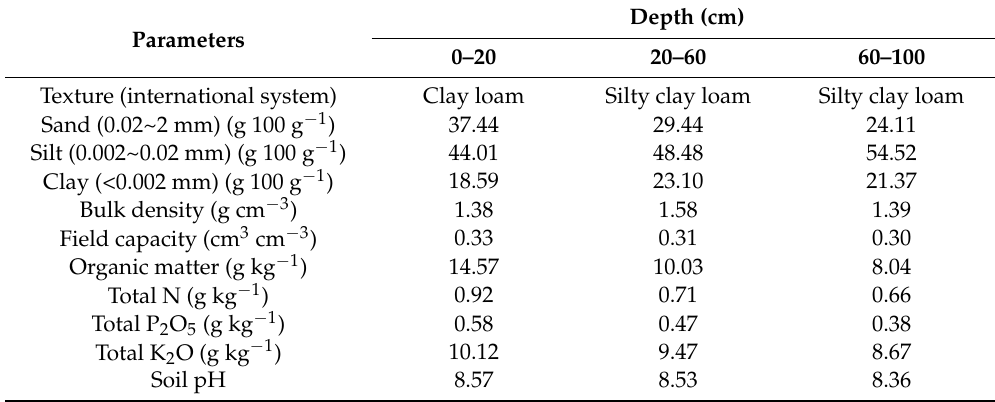
Table 1. Initial characteristics of the soil sampled in different soil layers in the experimental fields in